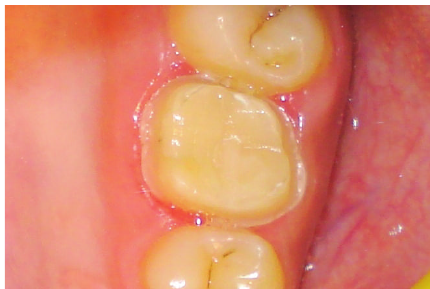
Figure 4: The tooth was prepared to receive metal-ceramic